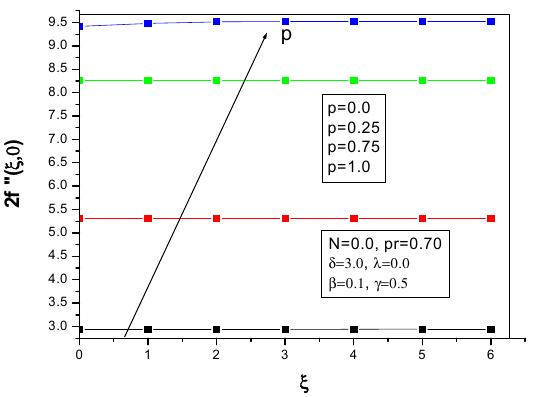
Figure 14. Effect of the velocity exponent and buoyancy force parameter on the skin friction coefficient.